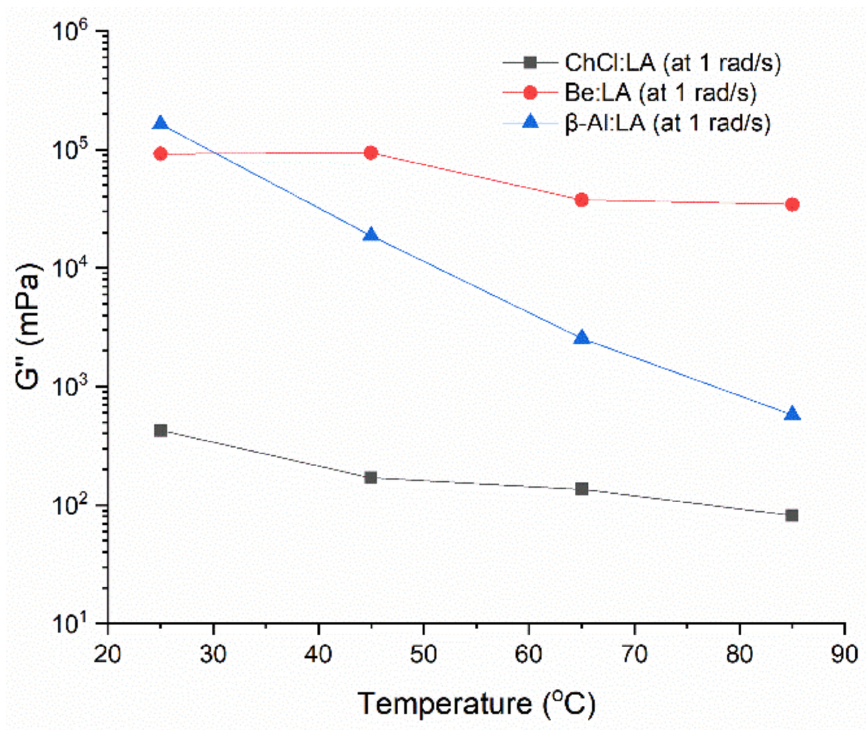
Figure 8. Viscous modulus (G (cid:48)(cid:48) ) at the low angular frequency at temperatures from 25–85 ◦